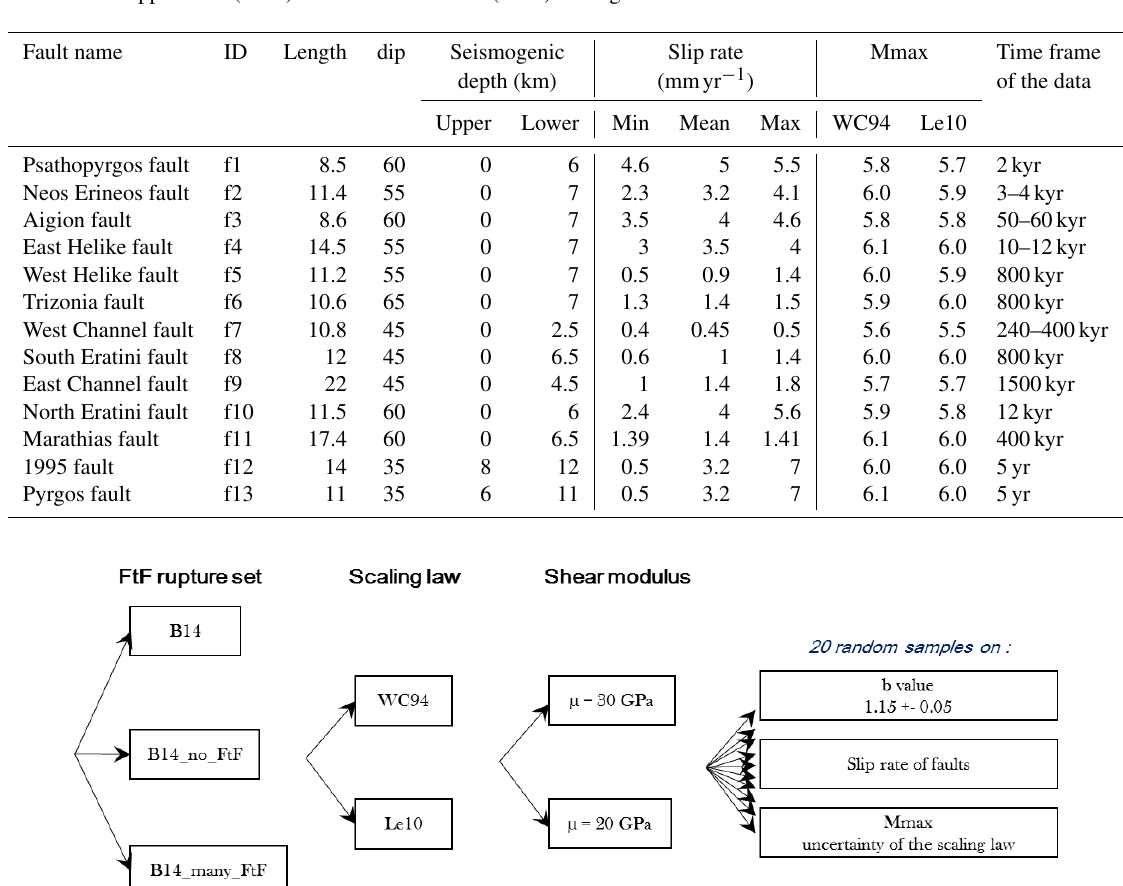
Table 1. Fault characteristics in Boiselet (2014). Mmax values calculated using the equations for normal faults using the rupture area. WC94 refers to Wells and Coppersmith (1994) and Le10 to Leonard (2010) scaling laws.